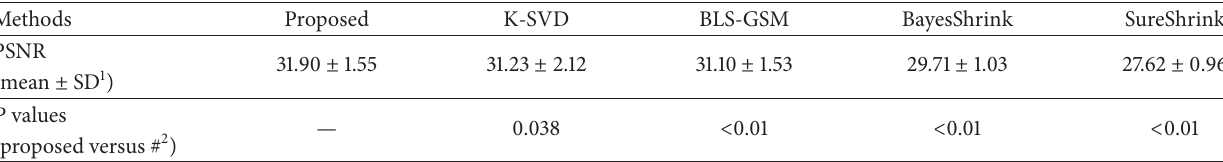
Table 3: The statistical comparison (Gaussian noise 𝜎 𝑛 = 20 ) between the proposed method and the other methods.